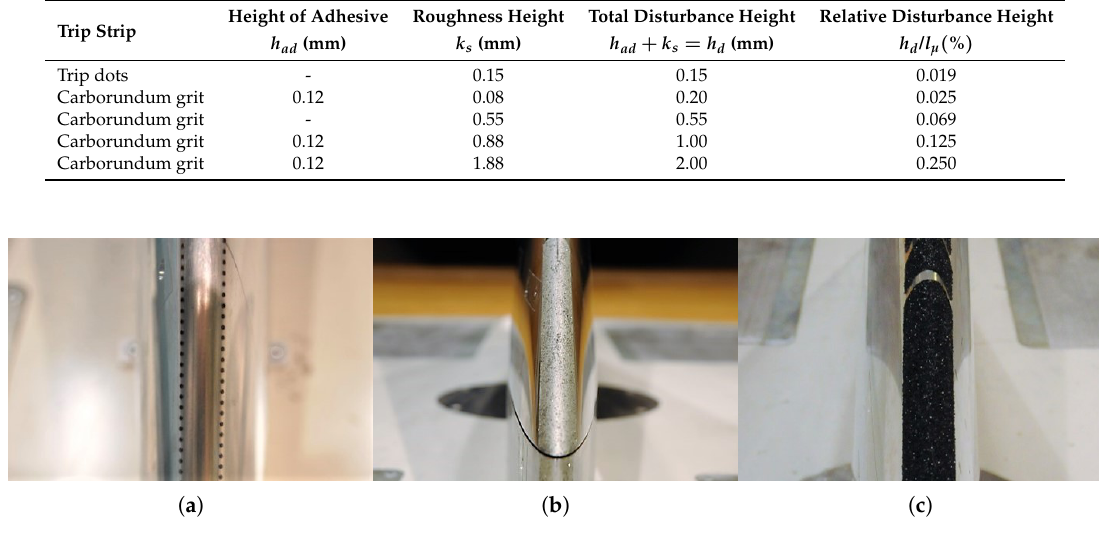
Figure 3. Applied trip strips. ( a ) Trip dots, h d / l µ = 0.019% ( h d = 0.15 mm); ( b ) Carborundum grit,